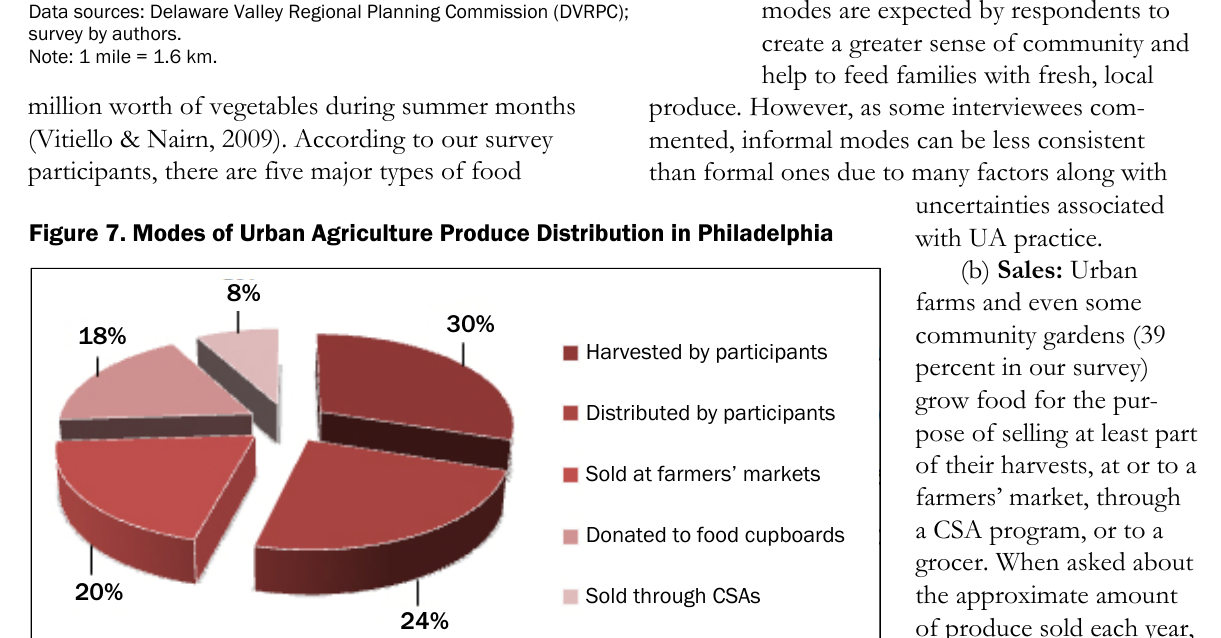
Data sources: Delaware Valley Regional Planning Commission (DVRPC); survey by authors.